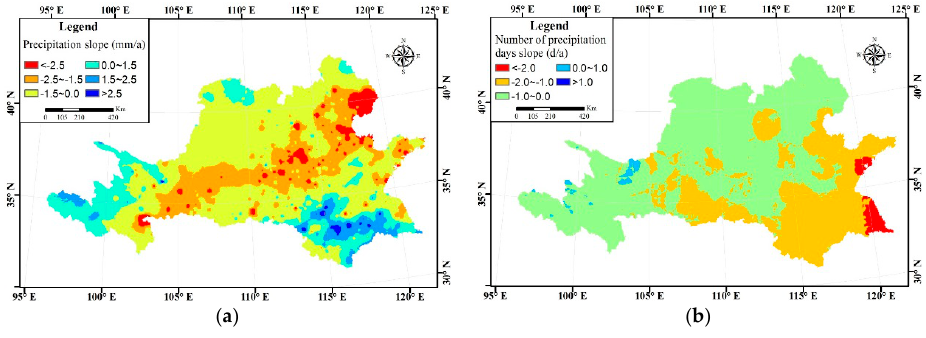
Figure 4. ( a ) Slope of precipitation; ( b ) rainy days.